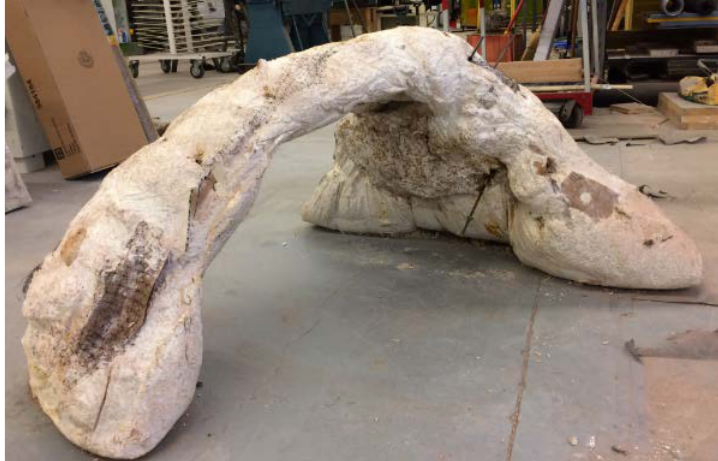
Figure 12 Mycelium Experiments of Jonathan Dessi-Olive-2017